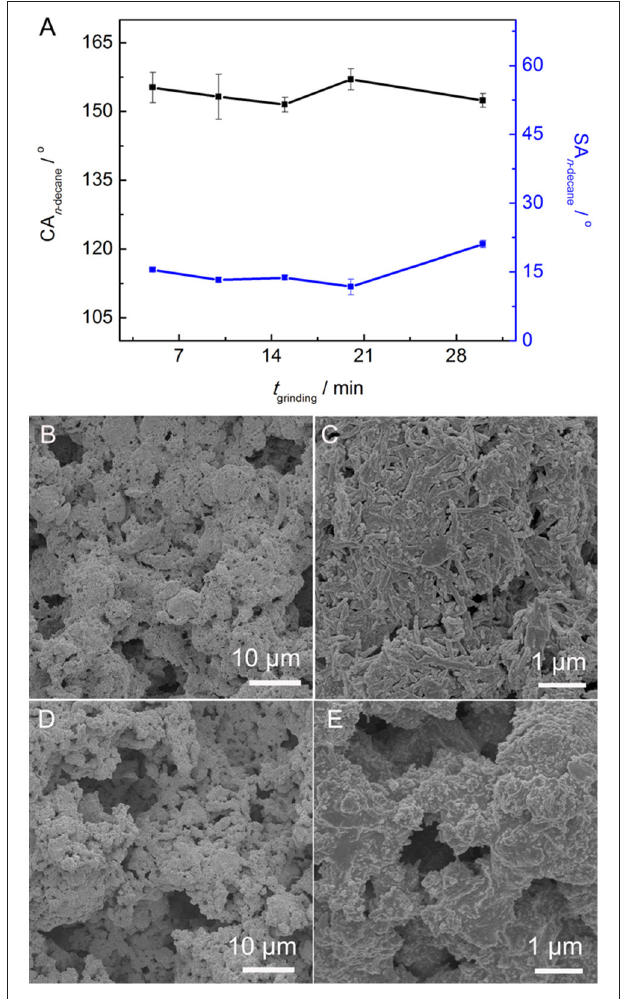
FIGURE 4 | (A) Variation of CA n − decane and SA n − decane of the PAL/IOR@fluoroPOS coatings with C PAL / IOR . SEM images of the coatings with a C PAL / IOR of (B,C) 6g L − 1 and (D,E) 20g L − 1 . t grinding = 20min, C PFDTES = 27.2mM, C TEOS = 4.5mM.